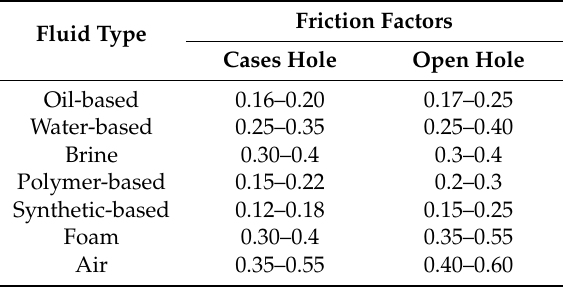
Table 1. Range of friction factors